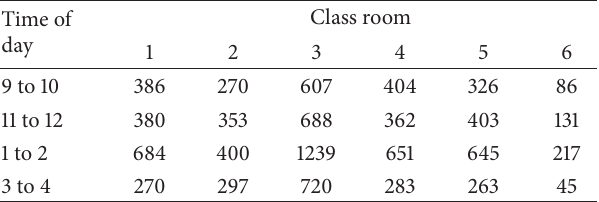
Table 11: Suggested operating hours of the lighting system of the classes.